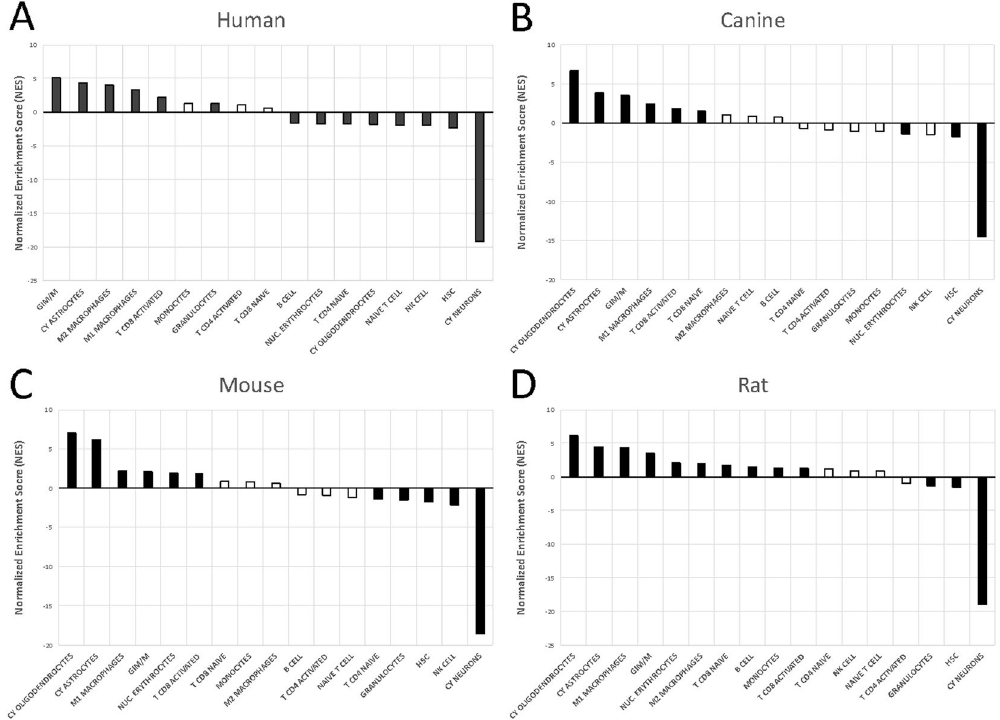
Figure 8. Gene set enrichment analysis. The DEG datasets were compared using GSEA incorporating cell type signatures for brain and infiltrating cell populations. ( A ) The human tumors showed an astrocytic predominance, whereas the three non-human species, ( B ) Canine, ( C ) Mouse, and ( D ) Rat, showed a mixed contribution of astrocytic and oligodendrocytic elements. Consistent with the expansion of glial components and displacement of neuronal components in gliomas, there was a significant decrease in the enrichment of the neuronal cell signature in tumors from all four species. Also, each species demonstrated evidence of activated cytotoxic T-lymphocytes (CD8 + ) and glioma-infiltrating macrophages and microglia (GIM/Ms). Only the human and rat tumors showed enrichment of the M2 macrophage signature. Black bars = FDR value < 25%; White bars = FDR ≥ 25%. [GIM/M: glioma-infiltrating macrophages and microglia; CY: Cahoy signatures; HSC: hematopoietic stem